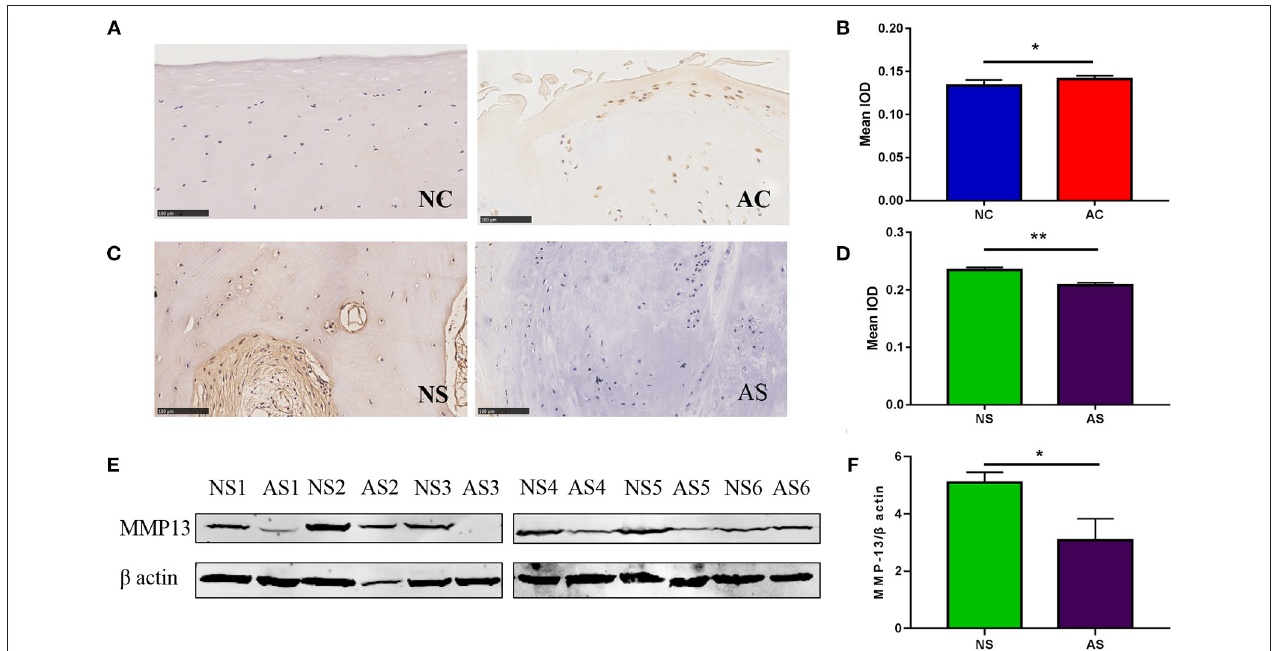
FIGURE 2 | MMP-13 expression in the cartilage and subchondral bone of patients with OA. The representative images of MMP-13 levels in the NC and AC (A) and the semiquantitative results of MMP-13 expression in the NC and AC (B) . NC represents less-worn cartilage, AC represents severe-worn cartilage; IOD indicates integrated optical density ( p < 0.05). The error bars indicate mean ± standard error of the mean. * p < 0.05. (C) The representative images of MMP-13 levels in the subchondral bone. NS represents less-worn subchondral bone, AS represents severe-worn subchondral bone. (D) The semiquantitative results of MMP-13 expression in the subchondral bone in the NS and AS. NS represents less-worn subchondral bone, AS represents severe-worn subchondral bone; IOD indicates integrated optical density. The error bars indicate mean ± standard error of the mean. * p < 0.05, ** p < 0.01. (E) Western blotting findings of MMP-13 expression in the subchondral bone. NS represents less-worn subchondral bone, AS represents severe-worn subchondral bone. (F) The quantification of western blot shows the expression of MMP-13 in subchondral bone. NS represents less-worn subchondral bone, AS represents severe-worn subchondral bone. The error bars indicate mean ± standard error of the mean. ** p <